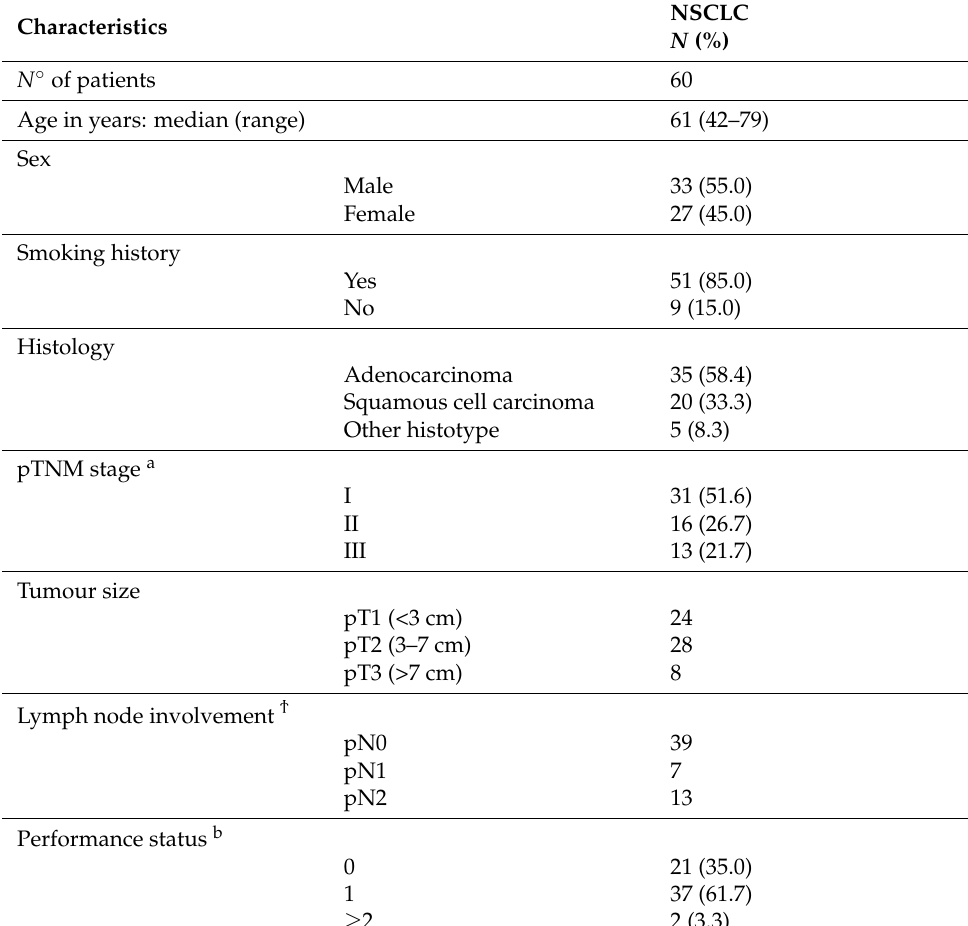
Table 1. Clinical and pathological characteristics of 60 non-small-cell lung cancer (NSCLC) patients.